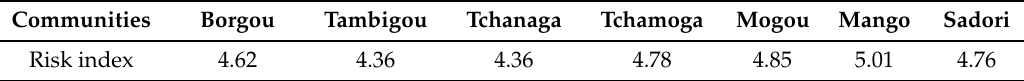
Table 10. Flood risk index of the different communities.